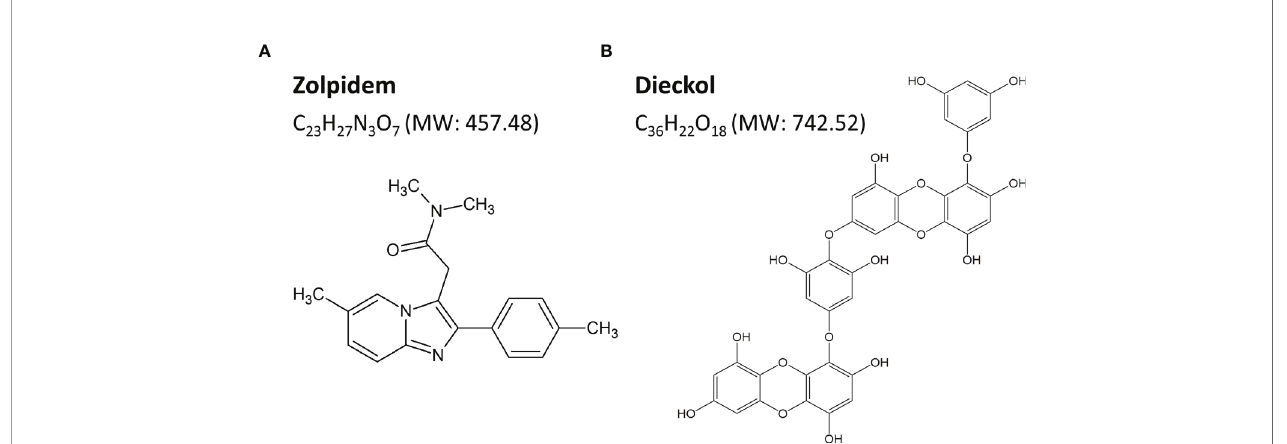
FIGURE 1 | Chemical structures and molecular weights (MW) of zolpidem (A) and dieckol (B)